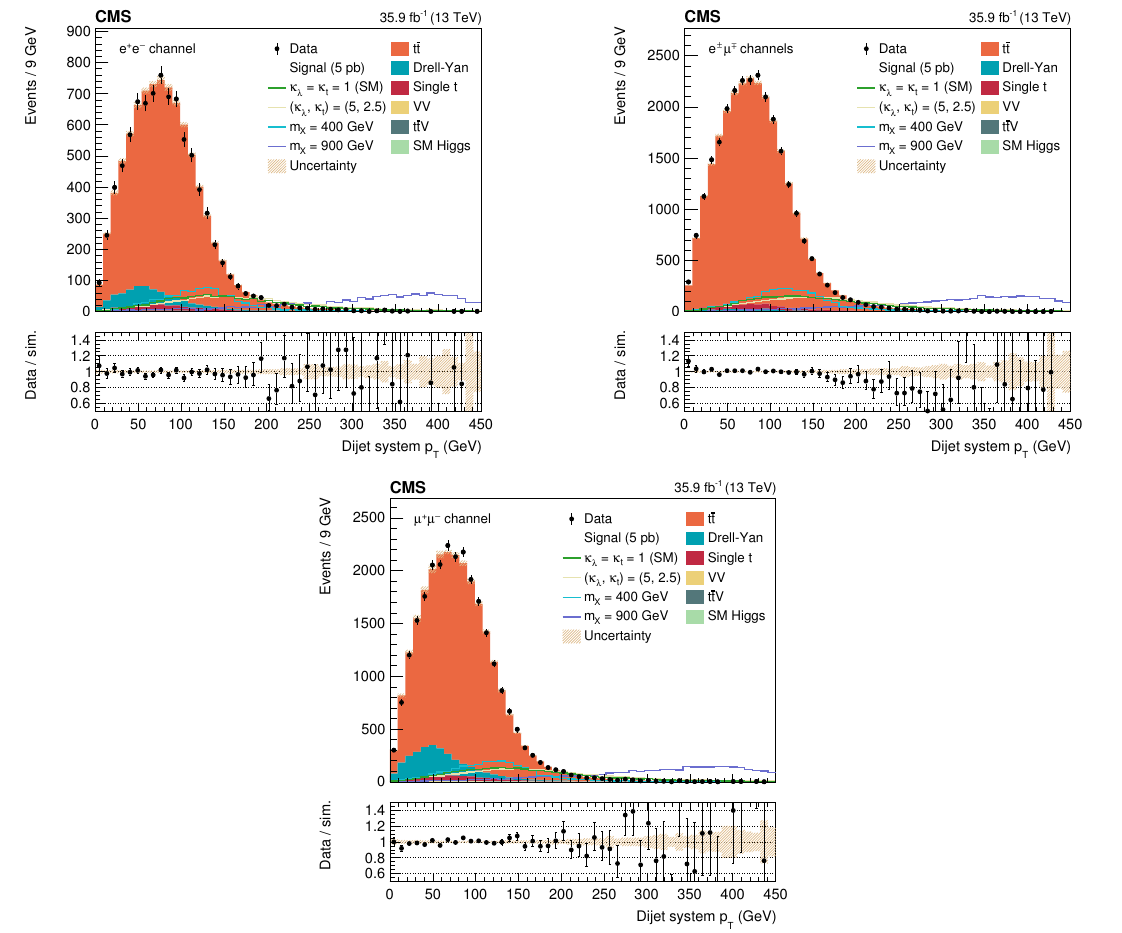
Figure 2 . The dijet p T distributions in data and simulated events after requiring two leptons, two b-tagged jets, and 12 < m ‘‘ < m Z (cid:0) 15 GeV, for e + e (cid:0) (top left), e (cid:6) (cid:22) (cid:7) (top right), and (cid:22) + (cid:22) (cid:0) (bottom) events. The various signal hypotheses displayed have been scaled to a cross section of 5 pb for display purposes. Error bars indicate statistical uncertainties, while shaded bands show post-(cid:12)t systematic